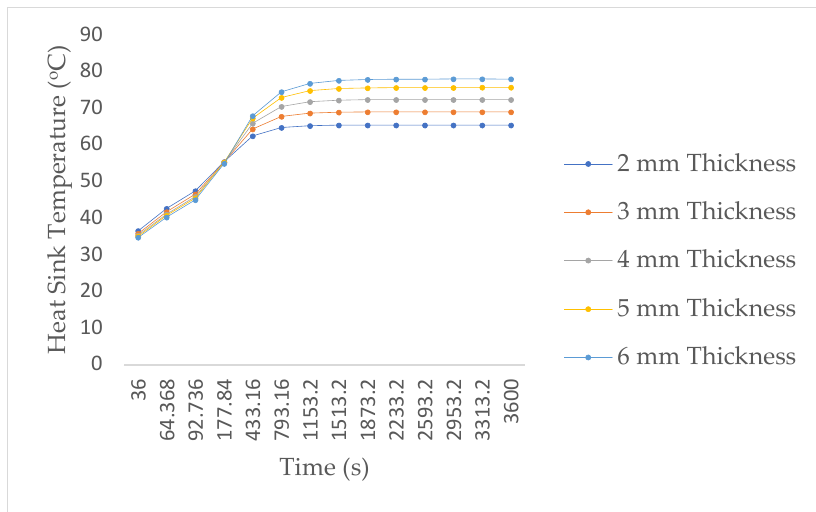
Figure 6. Temperature plot of heat sink at 15.03 W.